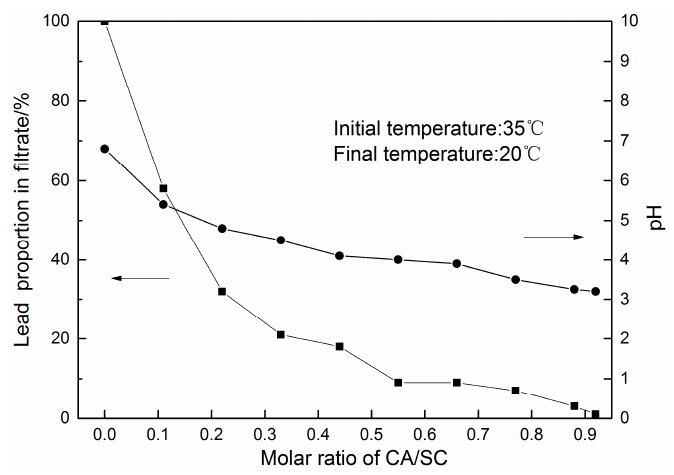
Figure 6. Lead proportion in filtrate with different molar ratios of CA/SC (initial temperature is 35 °C, final temperature is 20 °C).